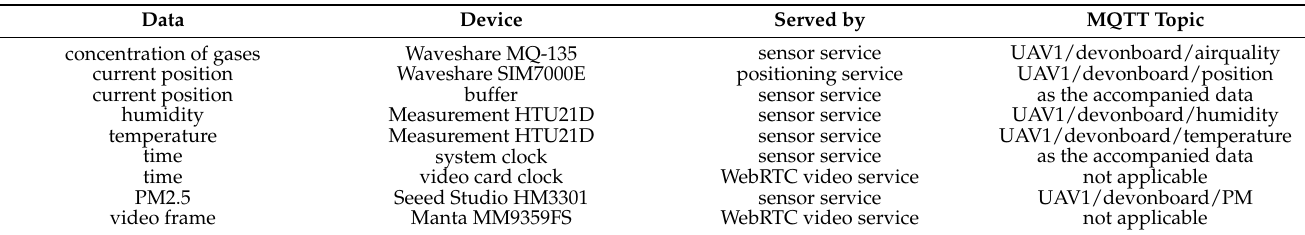
Table 2. Data and metadata transmitted between the air station and the ground